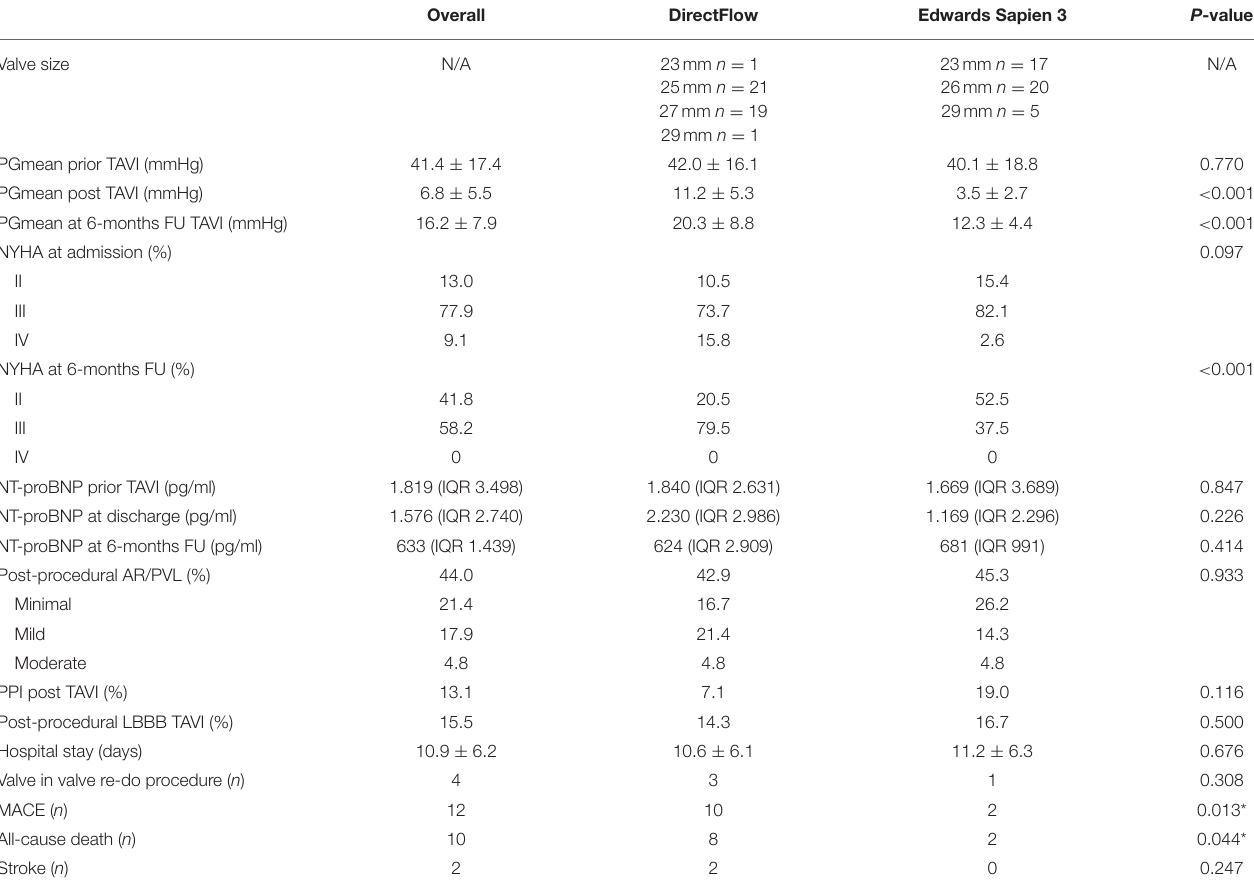
TABLE 3 | TAVI performance-Comparison DirectFlow vs. Edwards Sapien 3 (matched